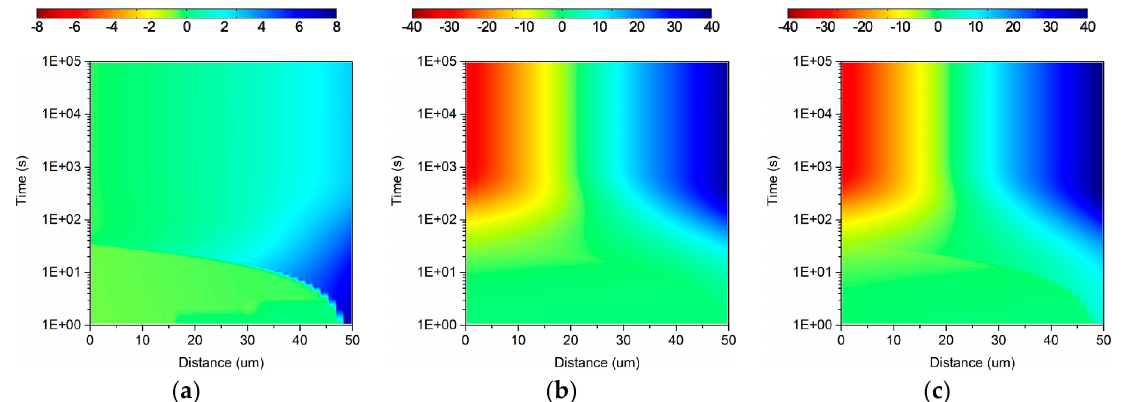
Figure 7. Space charge distribution at 40 °C: (a) mobile charge density (C/m 3 ); (b) trapped charge density (C/m 3 ); (c) total charge density (C/m 3 ).